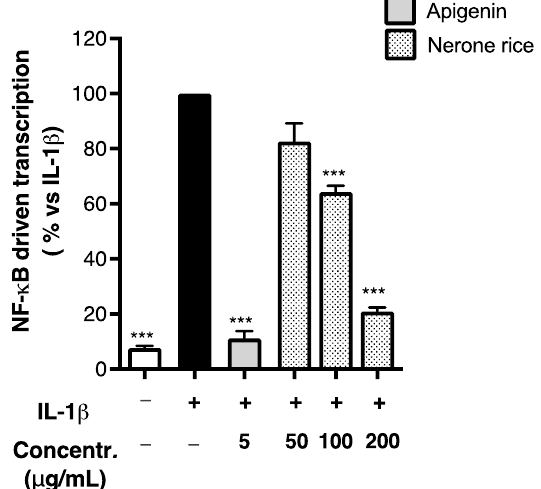
Figure 5. Effect of black rice extract from Nerone variety on the NF- κ B-driven transcription. Caco-2 cells were stimulated by IL- 1β (10 ng/mL) for 6 h. Unstimulated condition was also reported (white bar, Control − ). The NF- κB -driven transcription was measured by luciferase assay and expressed as mean ± SEM vs. stimulus (black bar, Control +), to which was arbitrarily attributed the value of 100%. *** p < 0.001 vs. stimulus.